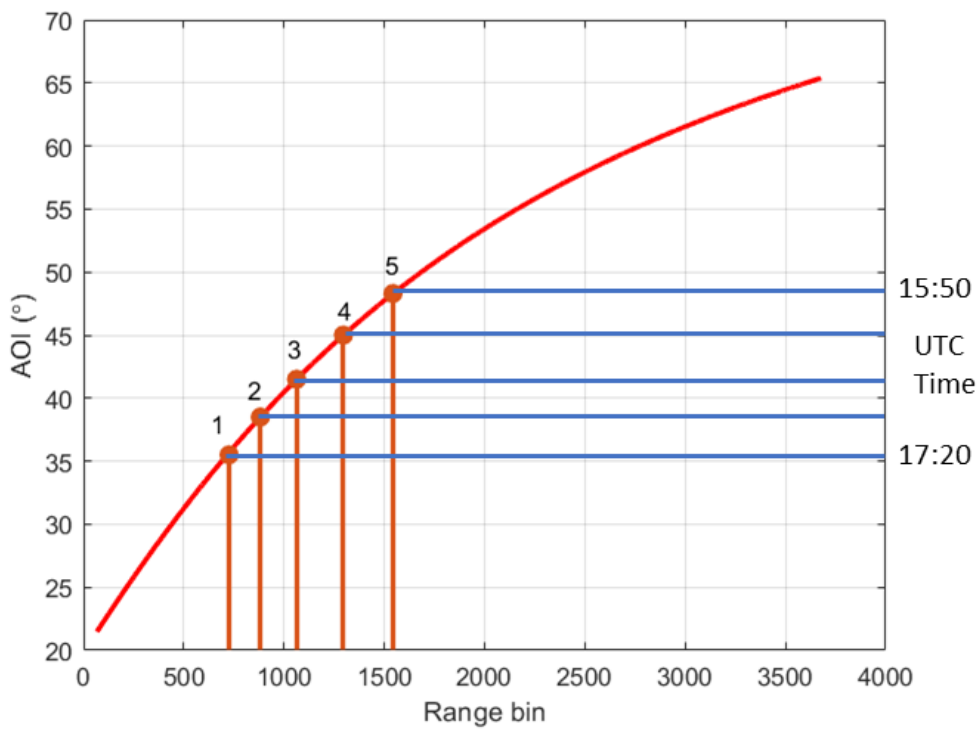
Figure 4. AOI versus range bin for the UAVSAR geometry. The AOI corresponding to the small ship to be analysed and the SAR acquisition UTC times are also annotated.